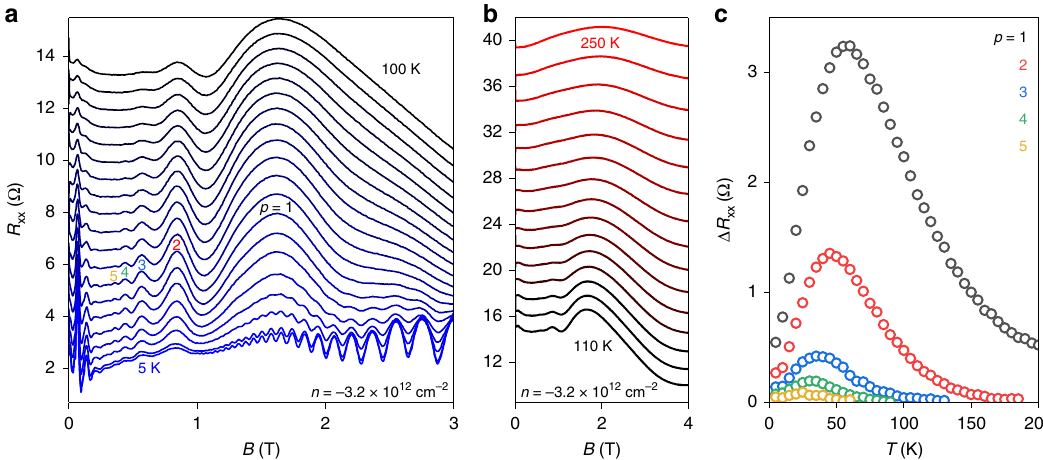
Fig. 2 Temperature dependence of the magnetophonon effect. a Magnetoresistance R xx ( B ) for T between 5 K (blue curve) and 100 K (black curve) in 5 K steps for fi xed n measured in another Hall bar with W = 15 μ m. b Extended data set of a showing high T behaviour (10 K steps). c Temperature dependence of the amplitude of MPR peaks, Δ R xx ( T ), indicated in a by colour coded letters, p = 1 –